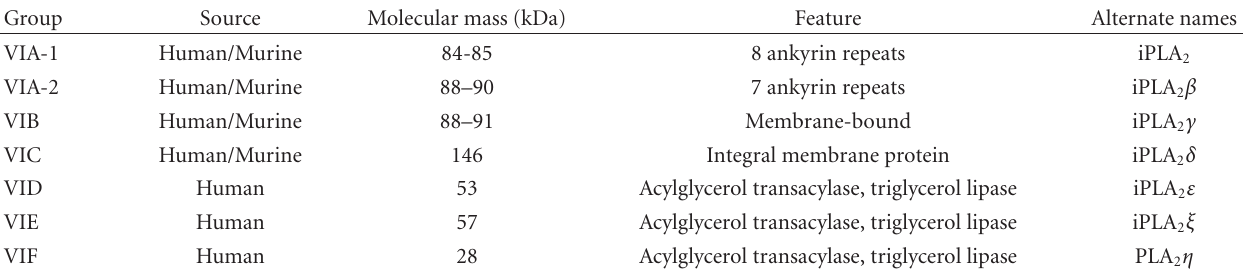
Table 1: Calcium-independent group VI phospholipase A 2 (iPLA 2